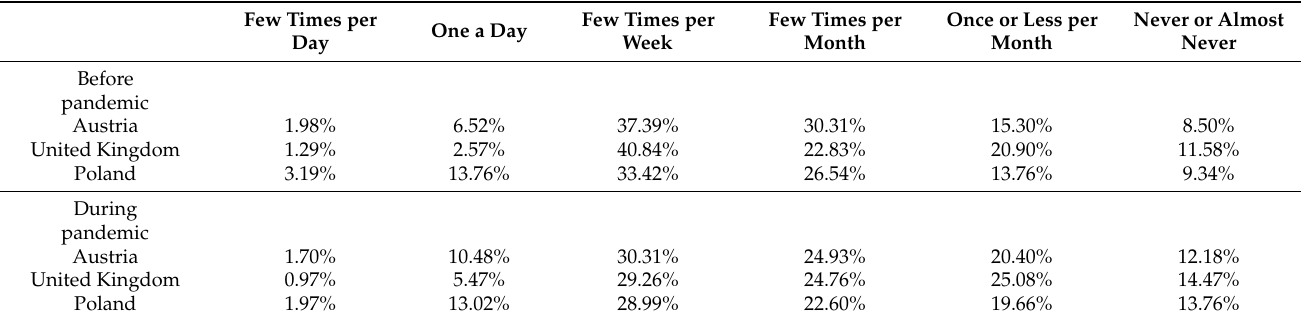
Table 4. Frequency of physical